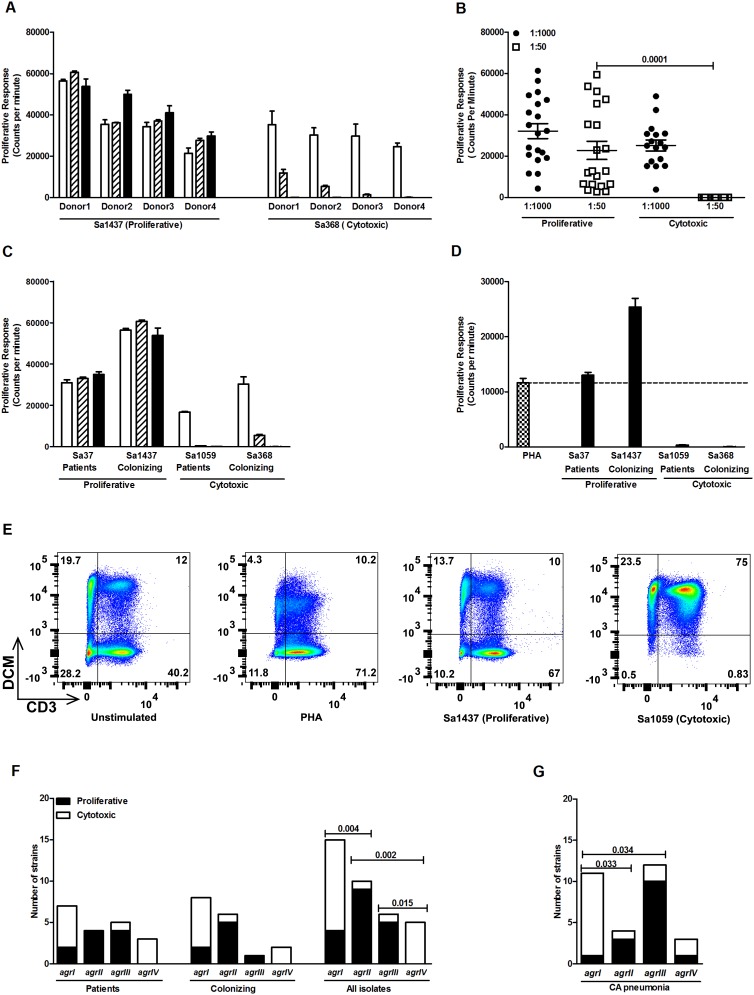
Proliferative or cytotoxic responses elicited by S. aureus strains.Human peripheral blood mononuclear cells (PBMC) isolated from healthy donors were stimulated with dilution series (1∶1000 (open), 1∶100 (stripped) and 1∶50 (filled) bars) of bacterial supernatants prepared from overnight cultures of S. aureus strains. Proliferative responses were determined by 3H-thymidine uptake and are presented as mean counts per minute ± SD. The supernatants induced either a proliferative or cytotoxic response profile. A cytotoxic profile was assigned when strains did not elicit a proliferative response in the more concentrated supernatants but only in the most diluted samples. A) Shows the response of a representative proliferative and cytotoxic supernatant in separate experiments using cells from four healthy donors. B) Scatter plot of proliferative responses induced by bacterial supernatants with a proliferative or a cytotoxic profile. Mean values of four different experiments are shown for dilutions 1∶1000 (filled symbols) and 1∶50 (open symbols). C) Bacterial supernatants with proliferative or cytotoxic profiles were found among both patients (n = 20) and colonized individuals (n = 17). The figure shows proliferative responses (mean ± SD) of one representative, out of five, experiments using cells from different donors stimulated with dilution series (1∶1000 (open), 1∶100 (stripped) and 1∶50 (filled) bars) of bacterial supernatants. D) To confirm a cytotoxic effect, proliferative responses were assessed in cells stimulated with PHA alone (the dashed line shows the average PHA response) or in combination with supernatants (proliferative and cytotoxic; dilution 1∶50 (filled) bars). The figure shows one representative of three experiments using cells from different donors. E) Flow cytometry analysis on PBMC stimulated with PHA and bacterial supernatants (1∶50 dilution). Total PBMC were gated based on CD45 expression and CD45 positive cells were further analysed for dead cell marker (DCM, Y axis) and CD3 (X axis) positivity. The figure shows one representative of three individual experiments using cells from different donors. F) Relation between agr types and proliferative (black bars) or cytotoxic (white bars) community S. aureus strains collected from colonizing individuals (n = 17) or patients with infections (n = 20) in India. G) Relation between agr type and proliferative or cytotoxic profiles elicited by community-acquired (CA) pneumonia patients (n = 31). Statistical significant differences were determined by use of the two-sided Mann Whitney test and Fisher's exact test with two sided p value and p values are indicated in the figure.